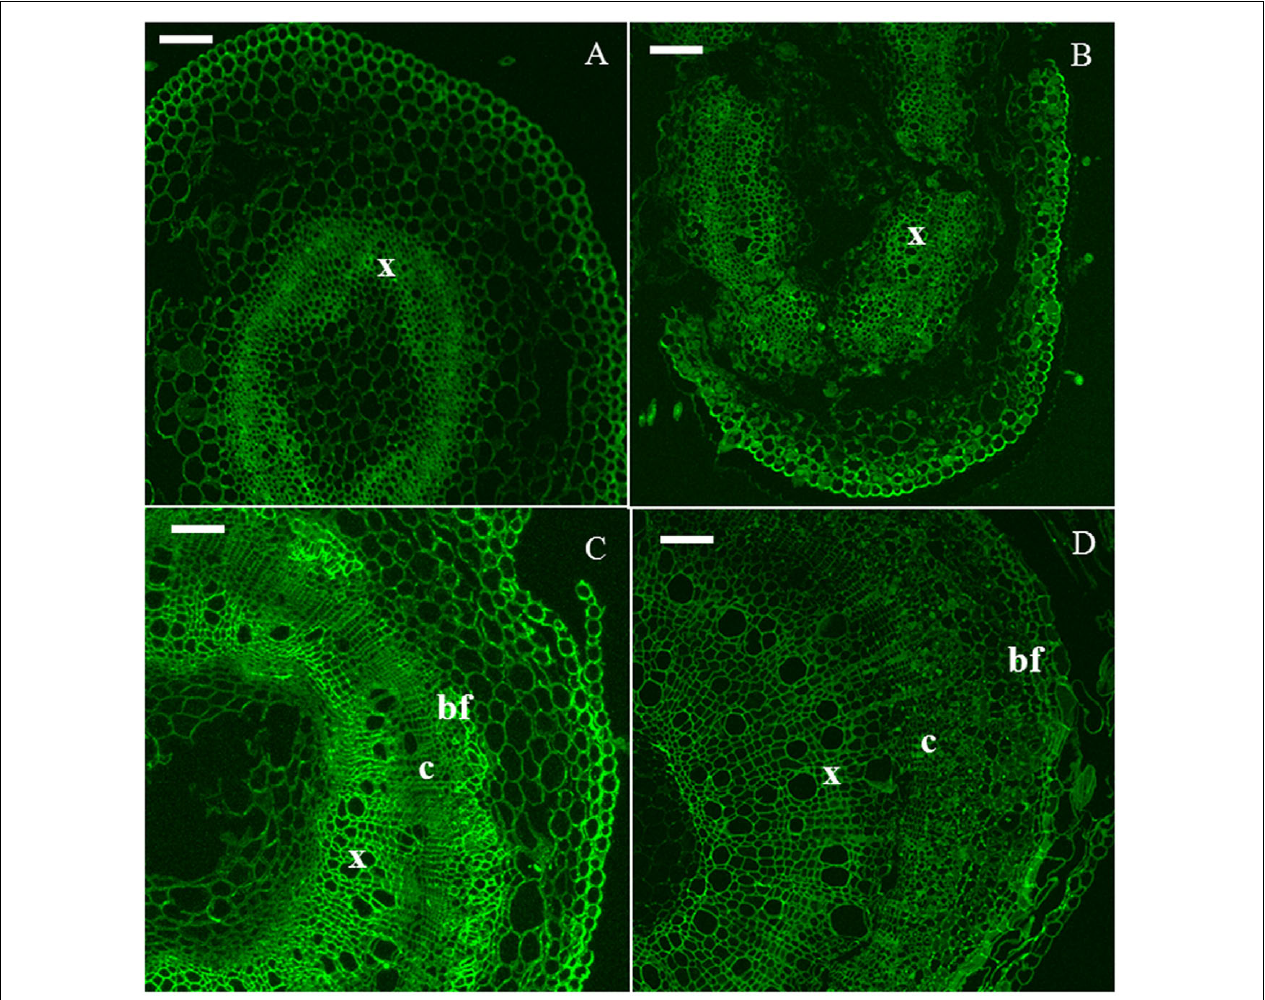
FIGURE 3 | Immunodetection of the LM15 epitope specific for xyloglucan. H6 ( A , top left), H9 ( B , top right), H15 ( C , bottom left), H20 ( D , bottom right). c, cambium; bf, bast fiber; x, xylem. Scale bar: 100 µ m.